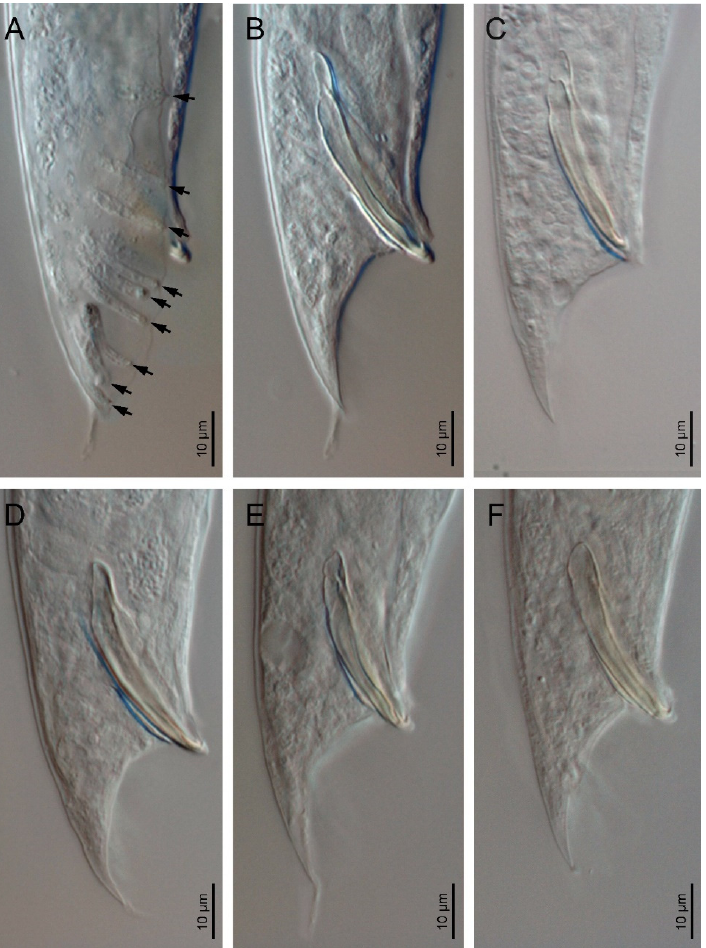
Figure 3. Oscheius siddiqii Tabassum and Shahina, 2010 (light microscopy). ( A ): Male posterior end at ventral view showing pattern of the genital papillae; ( B – F ): male posterior end at lateral view showing variations in spicules.